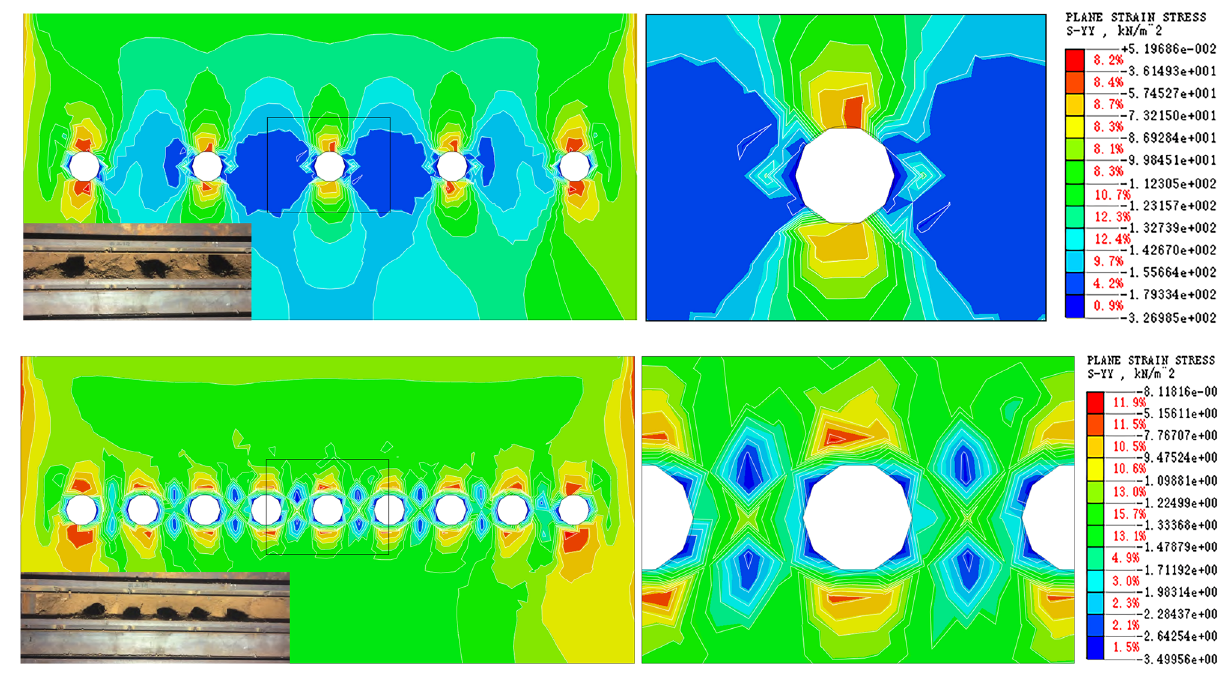
Fig. 10 Vertical stress comparison at 4 d and 2 d spacing